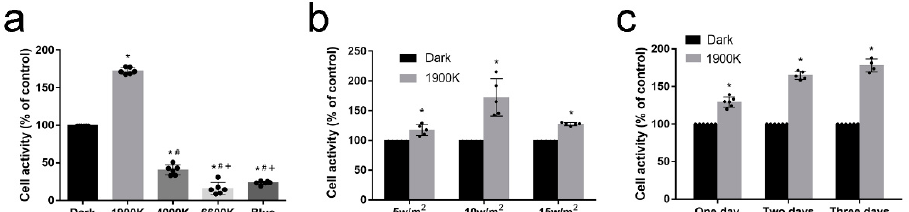
Figure 1. The low-color-temperature light-emitting diodes (LEDs) regulate cell activity according to irradiance and light time. ( a ) Cell activity after 48 h illumination of LEDs with different color temperatures at 10 W/m 2 ; n = 6. * Significantly different from dark group (one-way ANOVA, p < 0.0001); # significantly different from 1900 K group (one-way ANOVA, p < 0.0001); + significantly different from 4000 K group (one-way ANOVA, p < 0.0001). ( b ) Cell activity after 48 h illumination of the 1900 K LEDs with different radioactivity; n = 5. * Significantly different from dark group (two-sided, independent t -test: 5 W/m 2 , p = 0.0032; 10 W/m 2 , p = 0.0009; 15 W/m 2 , p < 0.0001). ( c ) Cell activity of ARPE-19 cells after 1900 K LED illumination at 10 W/m 2 for different times; * Significantly different from dark group (two-sided, independent t -test: 1 day, n = 6, p < 0.0001; 2 days, n = 5, p < 0.0001; 3 days, n = 4, p < 0.0001). The data are presented as the mean ±